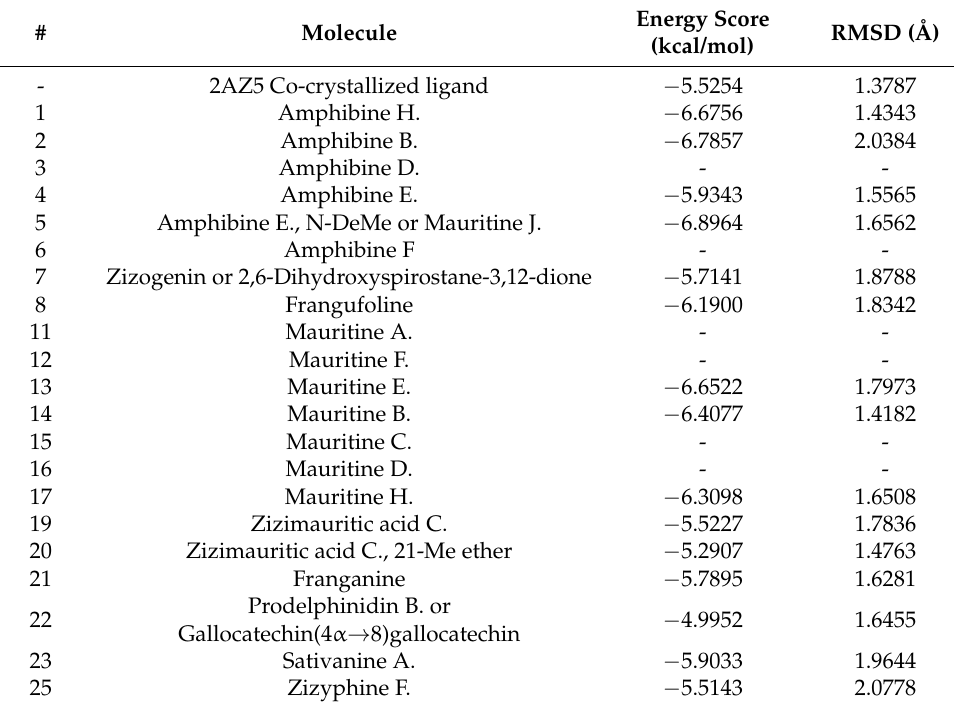
Table 3. Interaction binding energy (kcal/mol) and binding accuracy (RMSD; Å) of ZFE-derived compounds and co-crystallized ligand within TNF α active site (PDB ID: 2AZ5; 2.10 Å). #